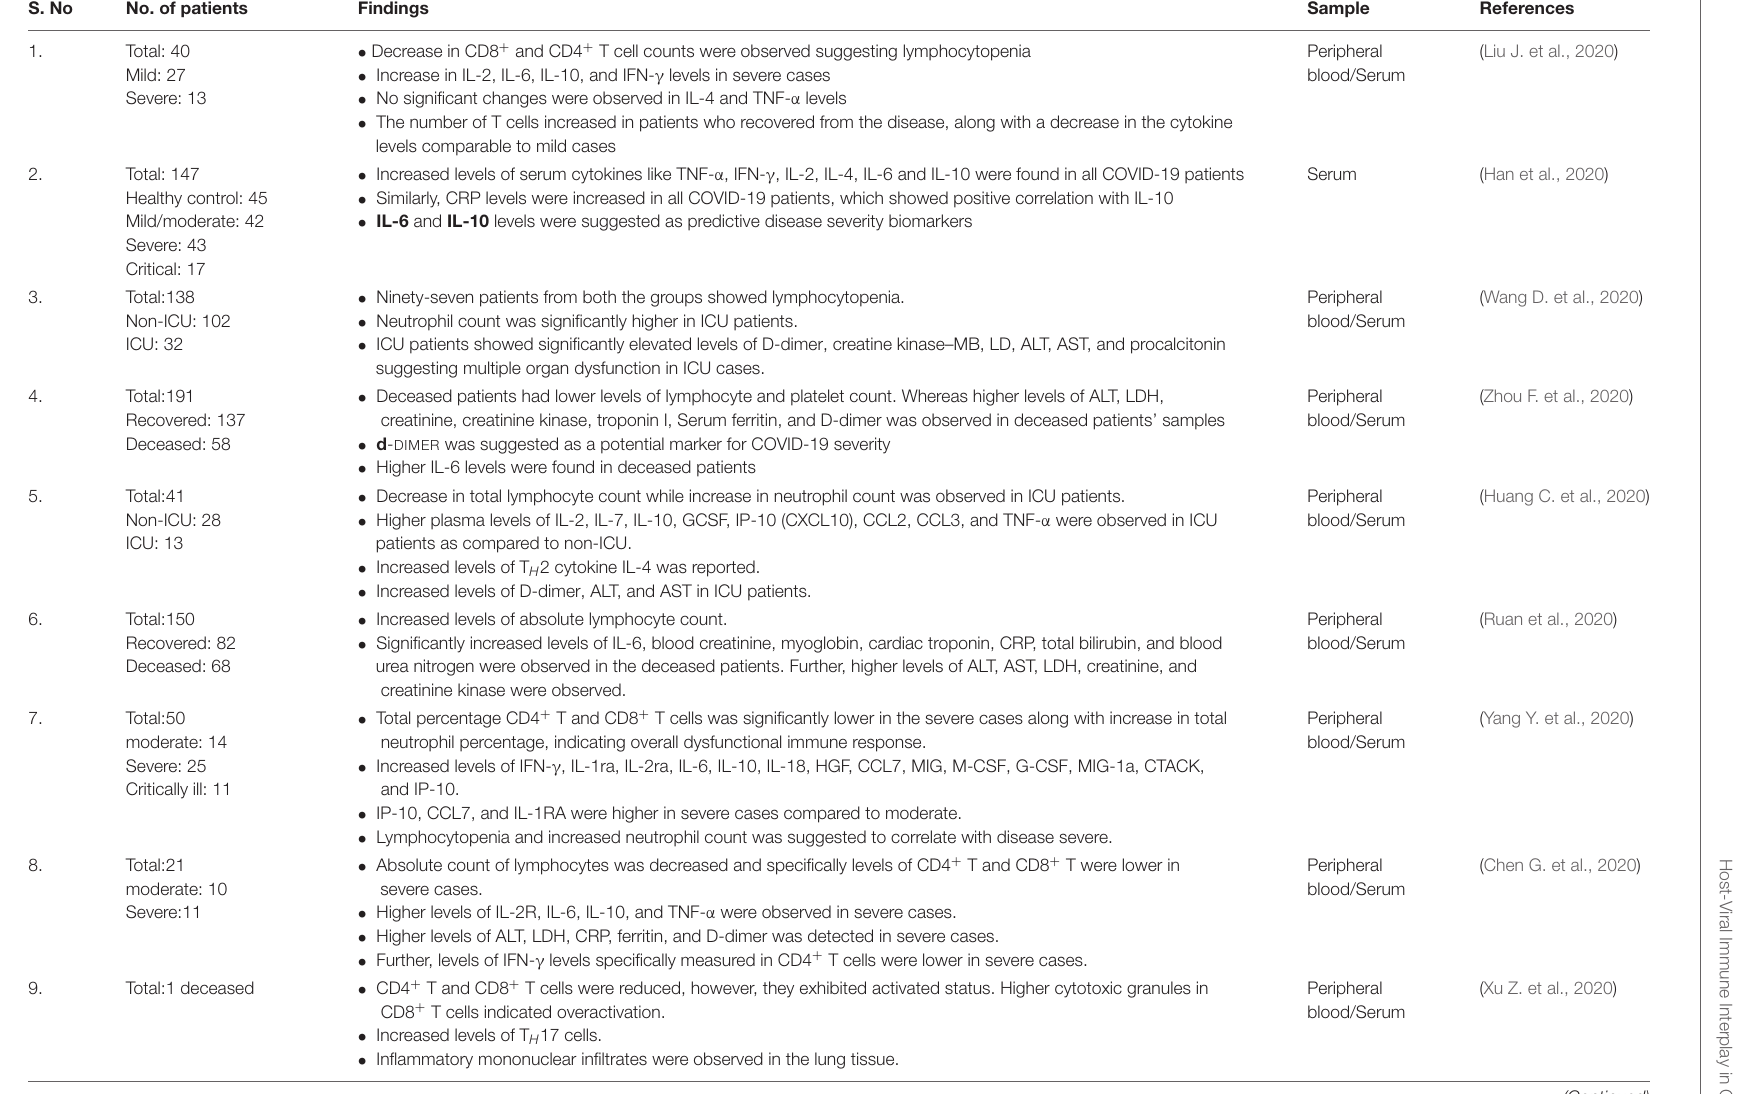
TABLE 1 | List of some research articles from December 2019 to May 2020 establishing lymphocytopenia and cytokine storm in COVID-19